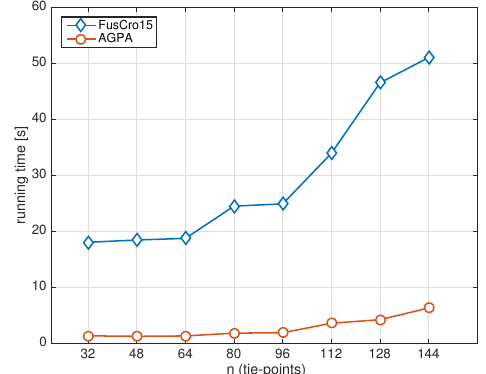
Figure 6. Running time vs number n of tie-points ( m = 16 , d = 10 , ray multiplicity = 6 ) for (Fusiello and Crosilla, 2015) and